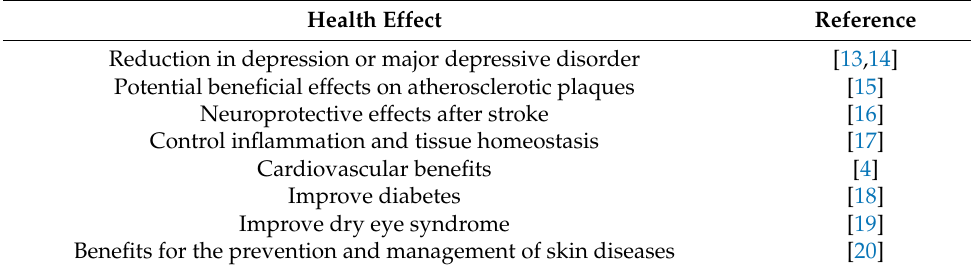
Table 1. Health Benefits of eicosapentaenoic